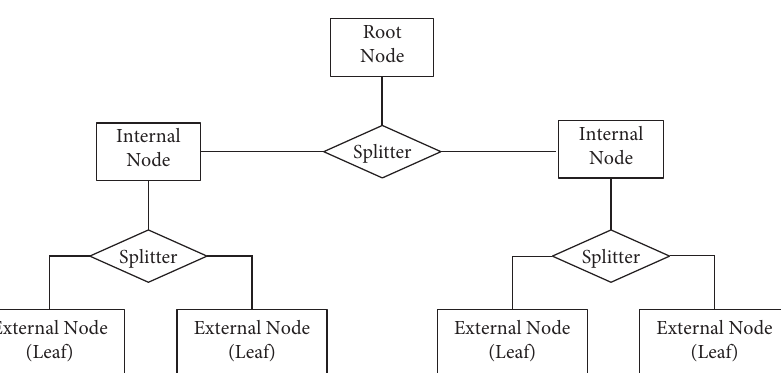
Figure 1: Basis of decision